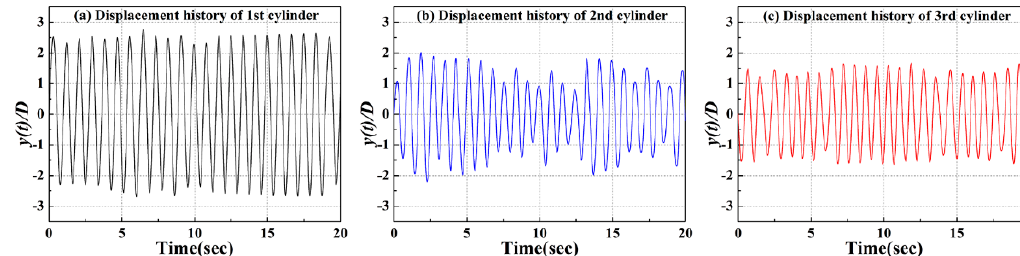
Figure 13. Time history curves of displacement for three cylinders when Re = 90,000.